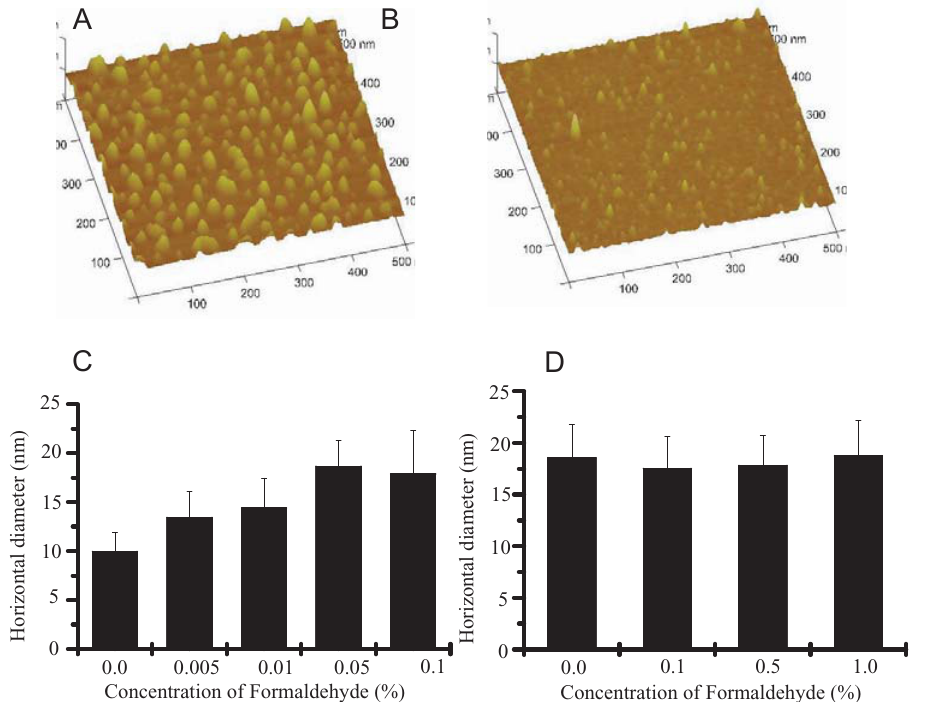
Figure 2. Three-dimensional images and horizontal diameters of tau at different concentrations of formaldehyde. The data using for regenerating three-dimensional images of neuronal tau in the presence (A) and absence (B) of formaldehyde solution (0.1%) are the same used for Figures 1A and E. Change in the horizontal diameter of the tau protein particles on mica surface at different concentrations of formaldehyde is depicted in C. Change in the horizontal diameter of BSA was used as control (D).